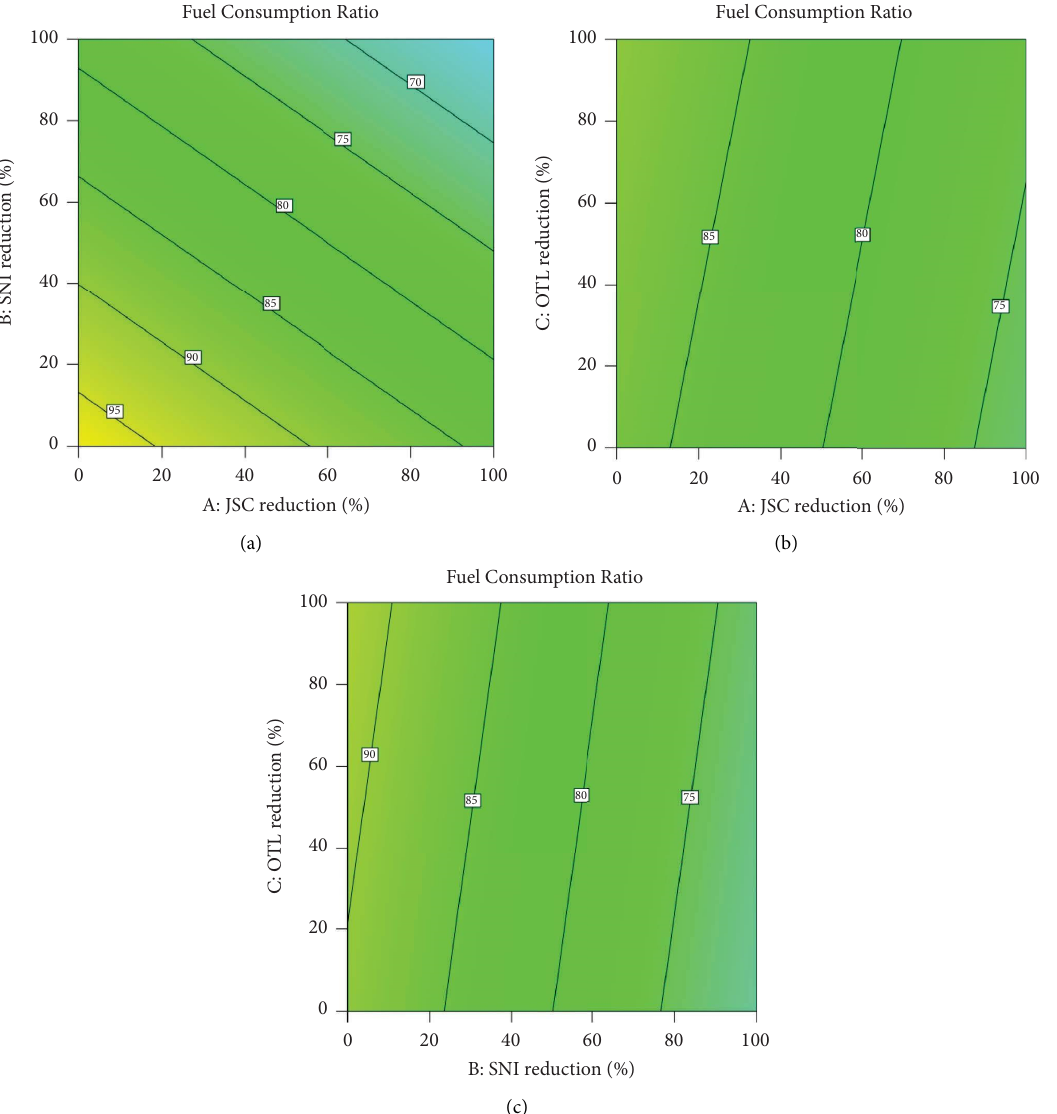
Figure 12: Two-dimensional contour plots of violations at intersections: (a) JSC versus SNI, (b) JSC versus OTL, and (c) SNI versus OTL for fuel consumption